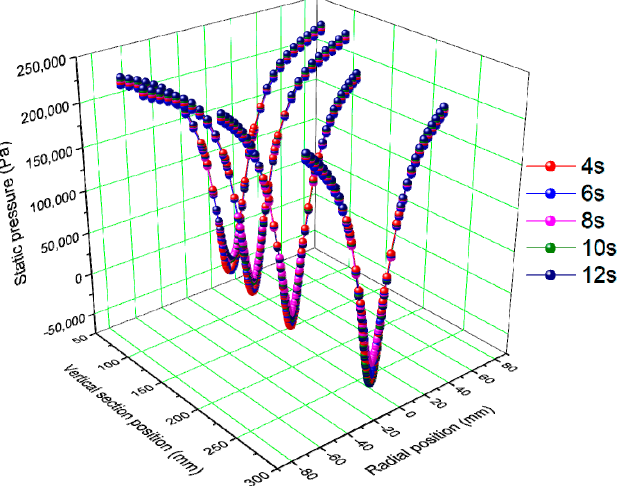
Figure 13. Distribution curve of static pressure.